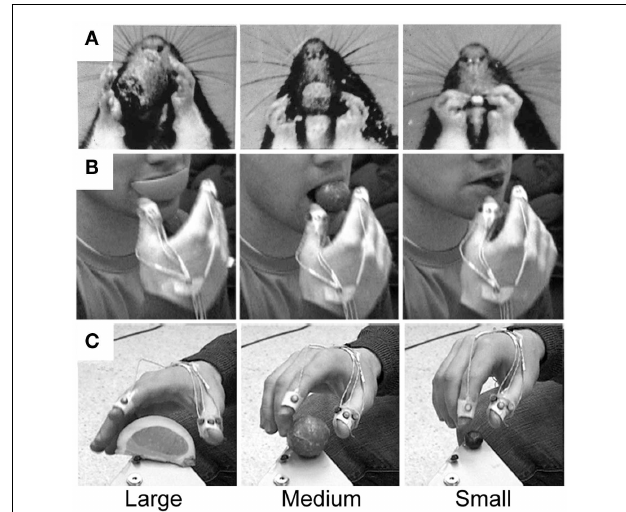
FIGURE 7 | Representative still frames illustrating hand preshaping before touching the target in (A) rat food handling movements, (B) human food handling movements, and (C) human visually guided Grasp movements . Note: in all three situations online haptic (food handling) or visual (Grasp) information is available to guide hand preshaping such that a large peak hand aperture is used to Grasp a large food item, an intermediate peak hand aperture is used to Grasp a medium-sized food item, and a small peak hand aperture is used to Grasp a small food item. Adapted fromWhishaw et al. (97) and Karl et al. (40).